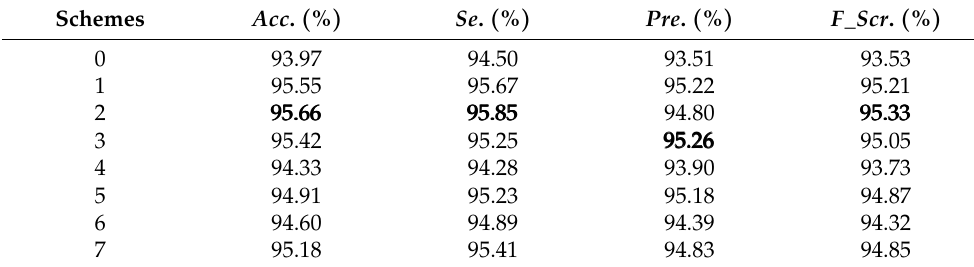
Table 1. Accuracies of different BN embedding